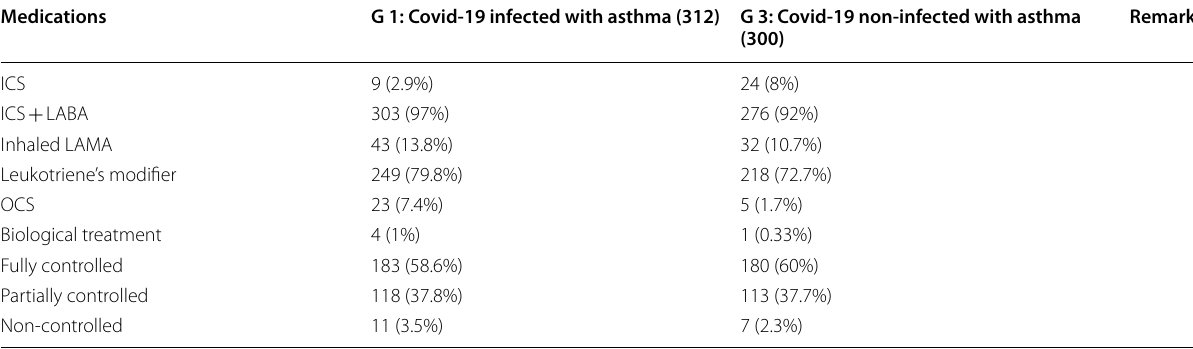
ICS Inhaled corticosteroids, LABA Long acting B2 agonists, LAMA Long acting muscarinic antagonists, OCT Oral corticosteroid